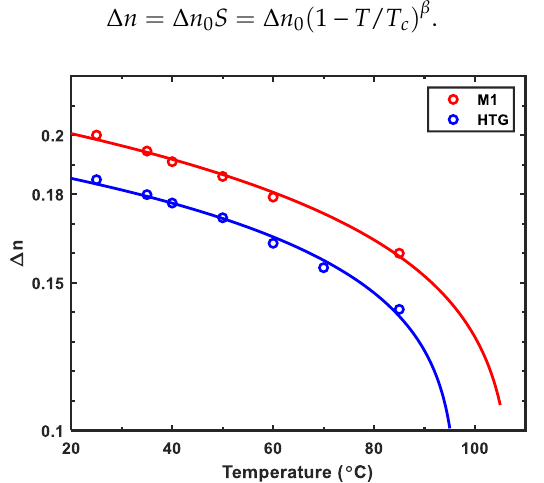
Figure 1. Temperature-dependent birefringence of M1 and HTG at λ = 1.06 μm and 1 kHz. Dots are experimental data and solid lines are fitting curves with Equation (2).